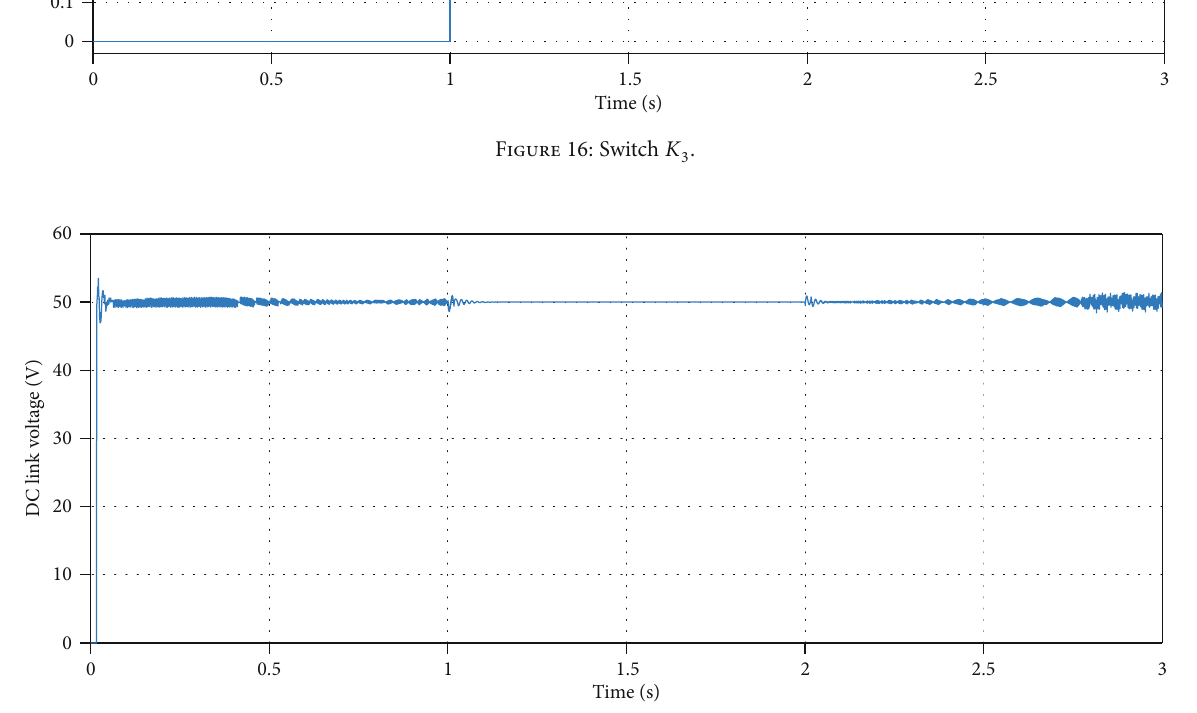
Figure 17: DC link voltage.